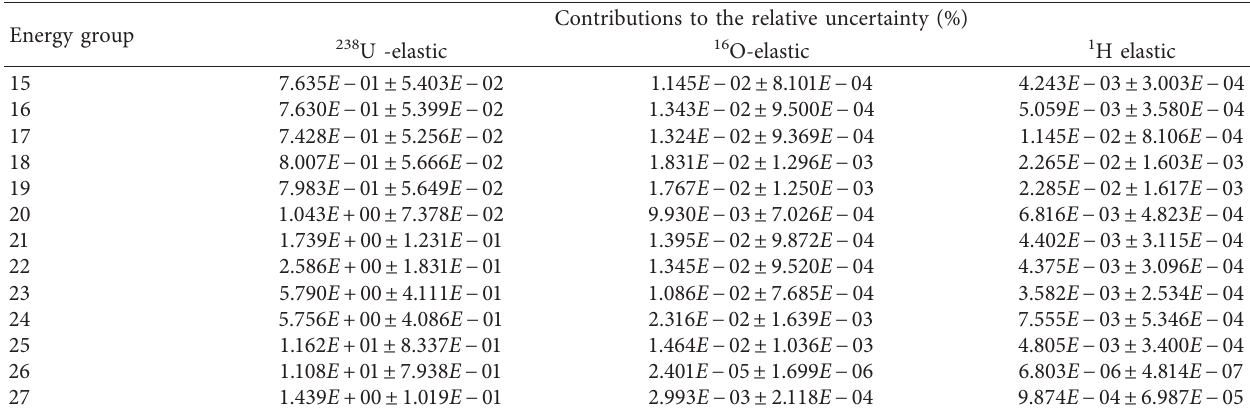
Table 3: The top 3 sources of uncertainty in 238 U effective resonance scattering XS. Energy group